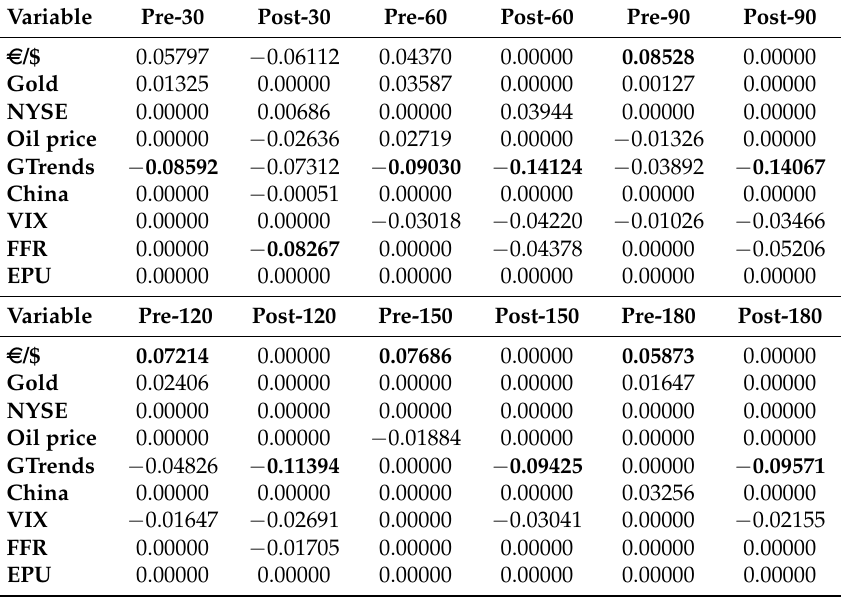
Figure A2. Cryptocurrency returns. Table A1. PC-LASSO coefficients for ethereum.